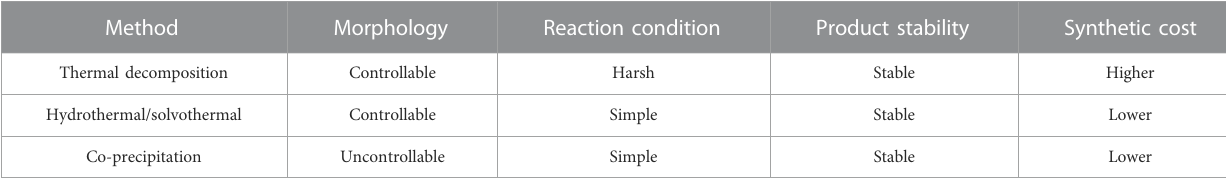
TABLE 1 Typical methods of Ln-UCNPs synthesis (Li and Lin, 2010; Du et al., 2011; Lin et al.,